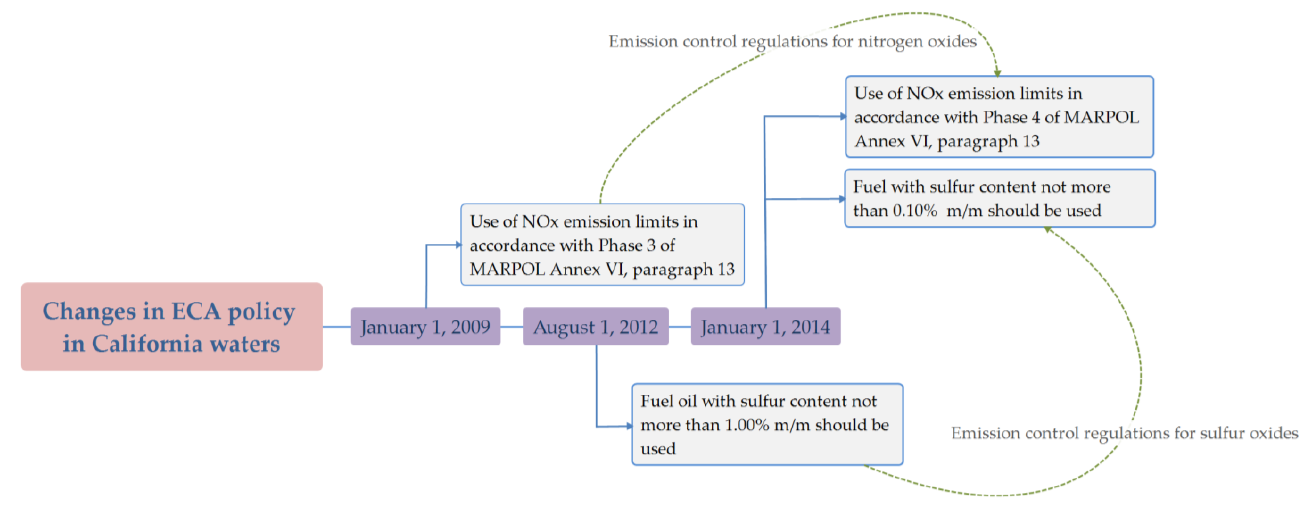
Figure 3. Policies changes of California ECA. Table 9. Pollutant emission factors in line with ECA policies (unit: g/kwh). Engine Type